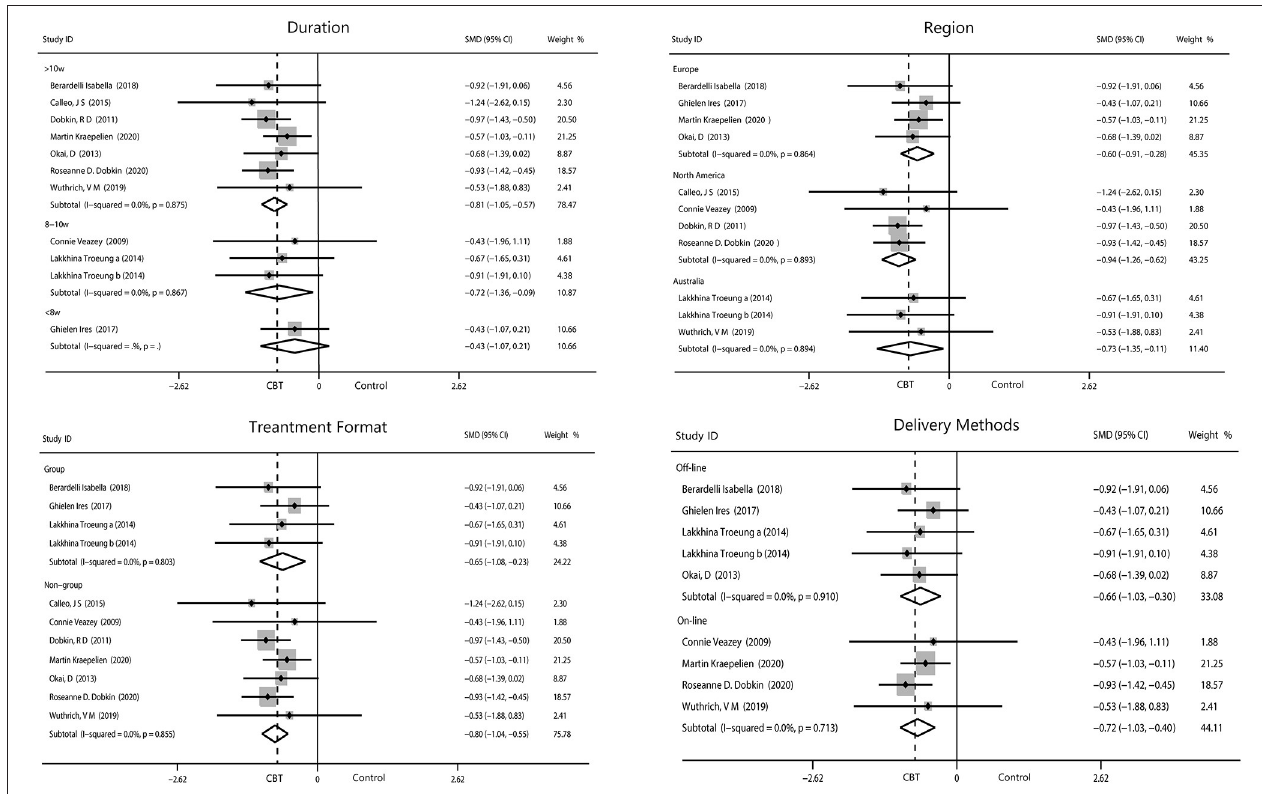
FIGURE 6 | Forest plot of random effects model meta-analysis of the effect of CBT on subgroups of anxiety. CBT, cognitive behavioral